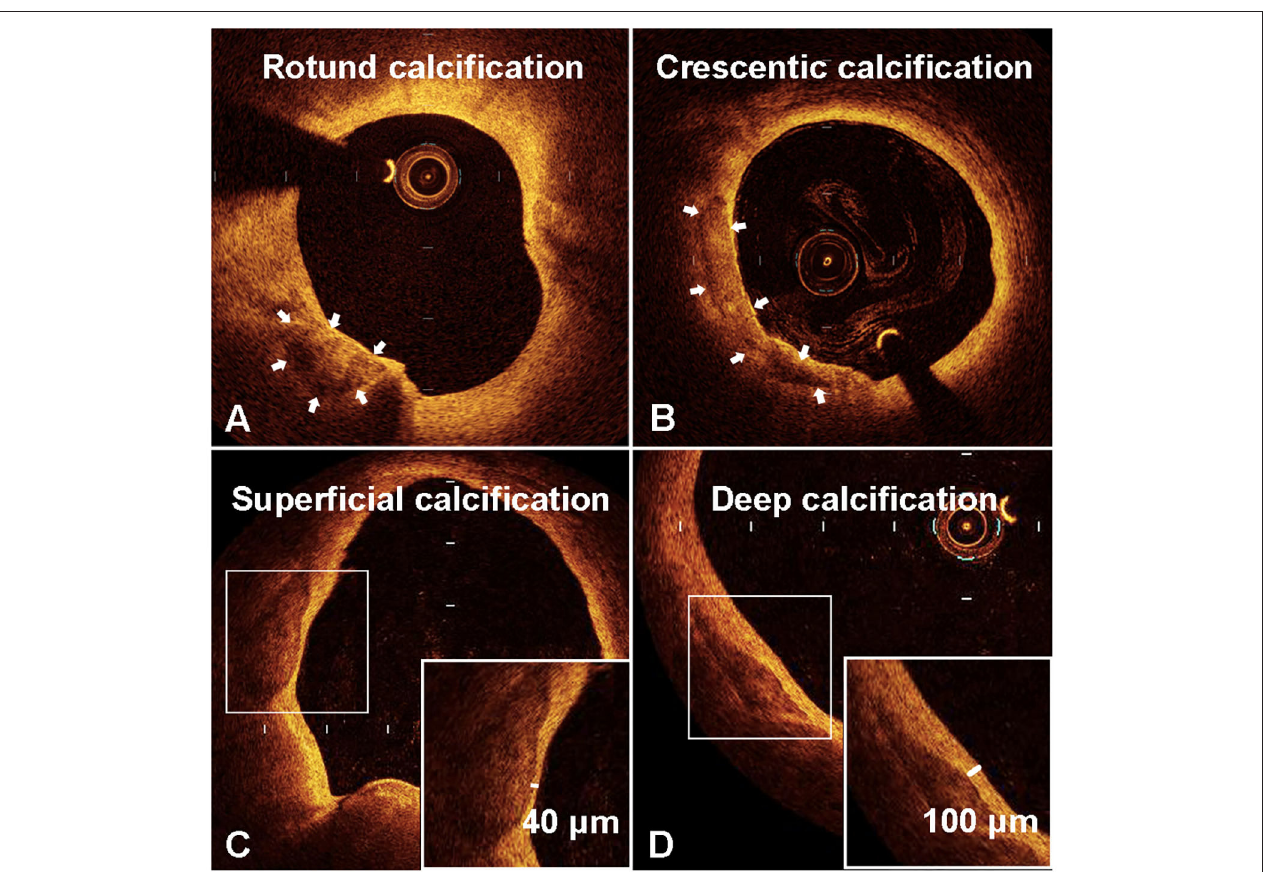
FIGURE 2 | Representative optical coherence tomography (OCT) images of rotund calcification (A) , crescentic calcification (B) , superficial calcification (C) , and deep calcification (D)